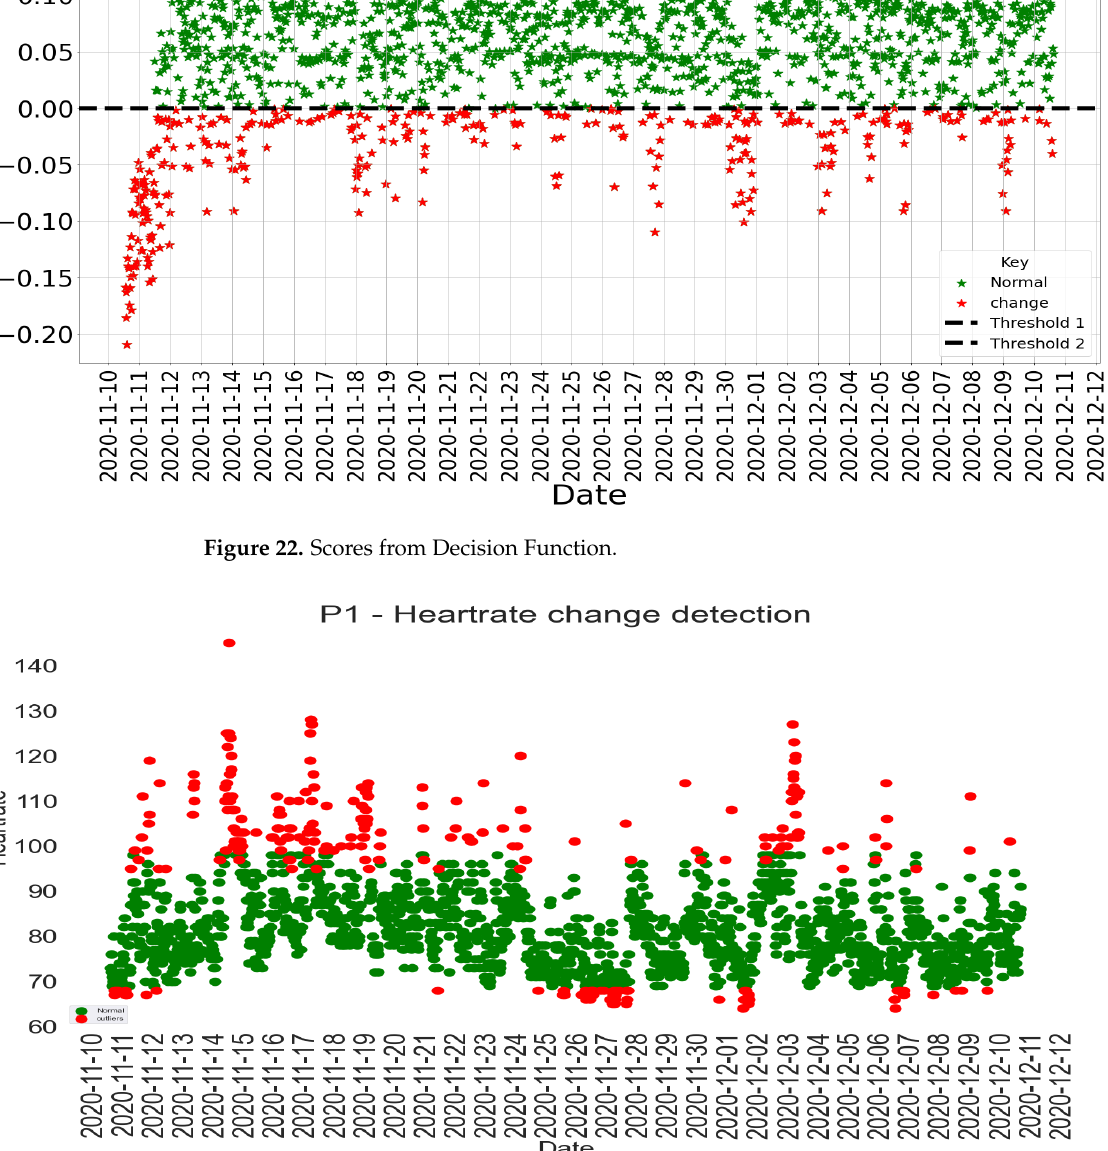
Figure 22. Scores from Decision Function.